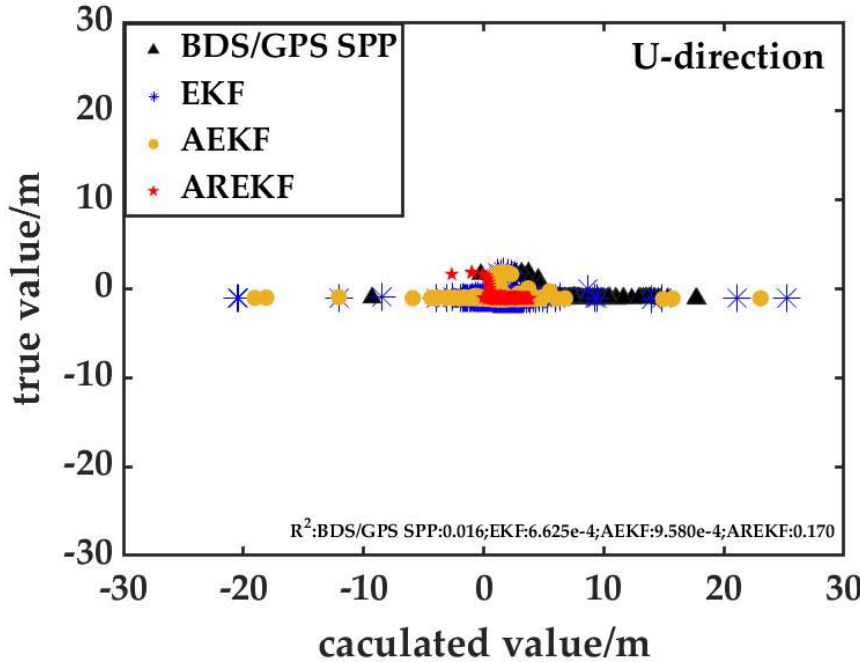
Figure 12. Correlation analysis between positioning results and reference values of each positioning scheme in U-direction.